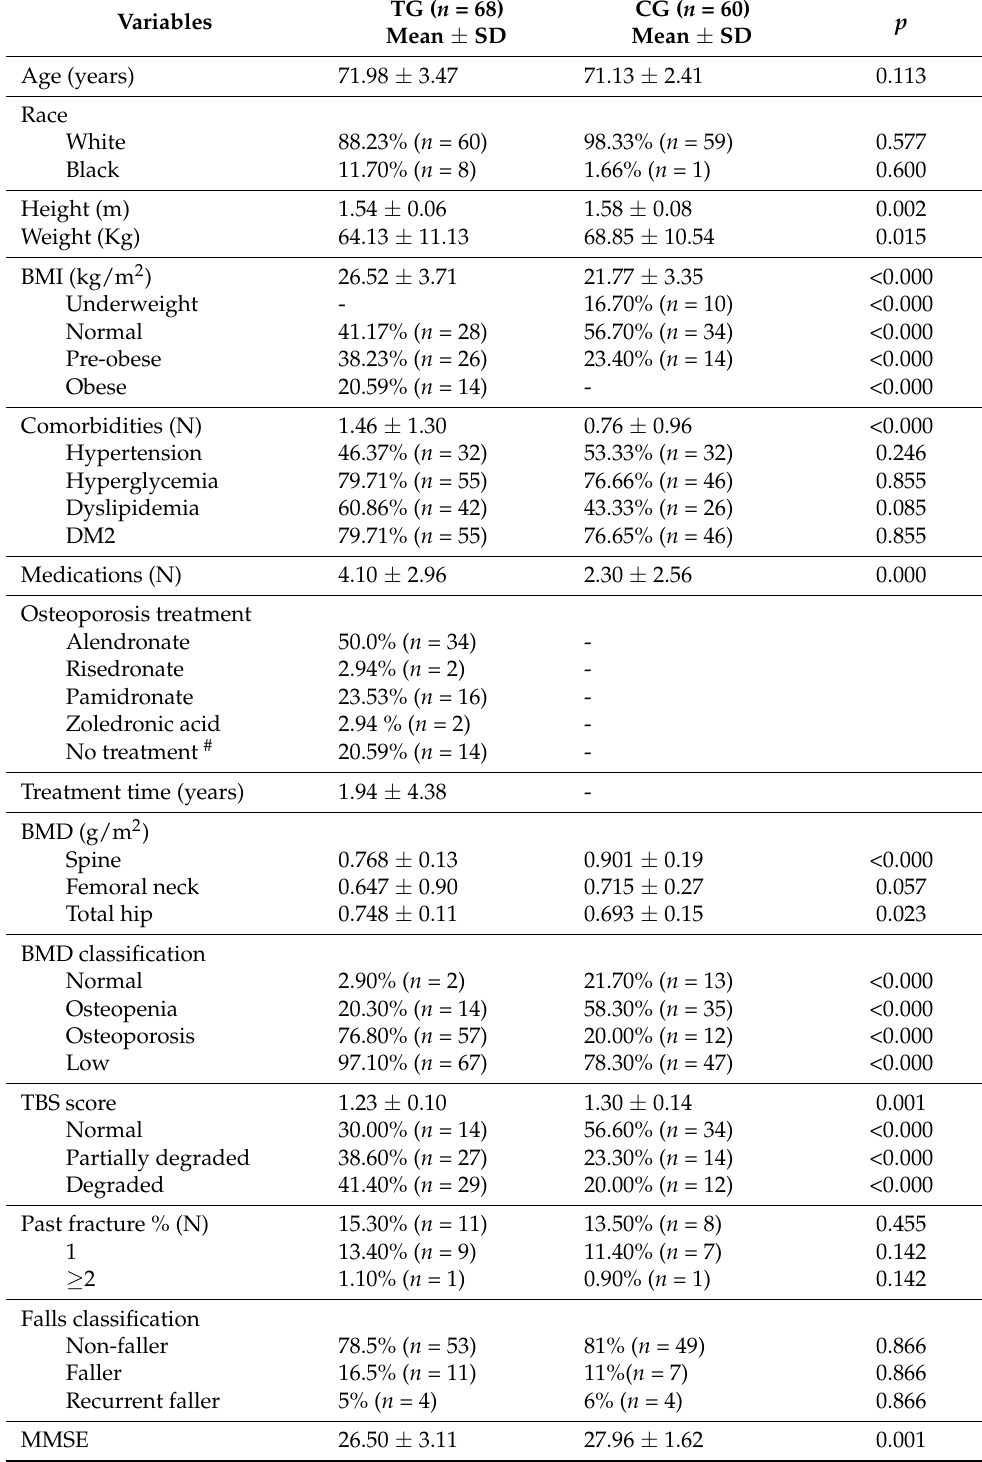
Table 1. Anthropometric data of patients and